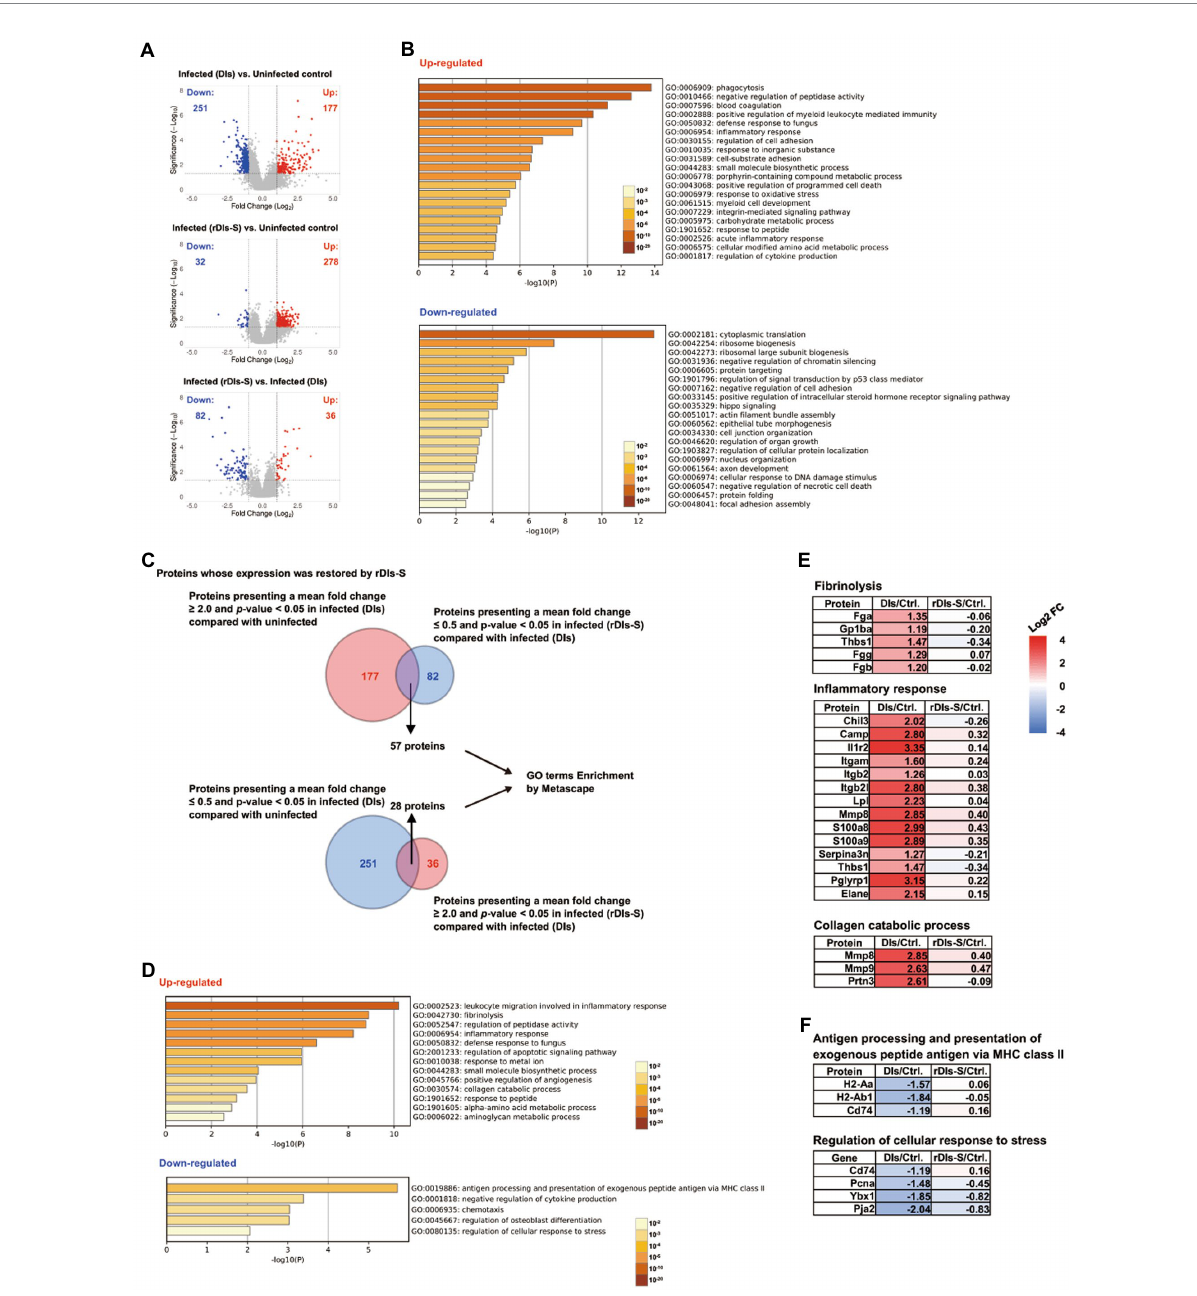
FIGURE 5 Proteomic analysis in vaccinated mice following SARS-CoV-2 infection. The protein expression levels in the lung tissues of hACE2 transgenic mice 7 days after challenge infection were analyzed using multiplex peptide labeling and mass spectrometry (MS). (A) Volcano plot for differentially expressed proteins. Comparison of the protein expression levels between uninfected mice and infected mice inoculated with DIs (top), between uninfected mice and infected mice inoculated with rDIs-S (middle), and between infected mice inoculated with DIs and infected mice inoculated with rDIs-S (bottom). x -axis: expression ratios. y -axis: p values of the comparisons. Vertical dotted lines indicate a 2-fold increase or decrease in the protein level in mice inoculated with DIs or rDIs-S. Horizontal lines indicate a p value of 0.05 from a Chi-squared test. Red circles: proteins with concentration increases of more than 2.0-fold in each comparison (DIs vs. Uninfected, rDIs-S vs. Uninfected, and rDIs-S vs. DIs); blue circles: proteins with concentrations decreased to less than half in each comparison (DIs vs. Uninfected, rDIs-S vs. Uninfected, and rDIs-S vs. DIs). (B) The top-20 gene ontology (GO) enrichment terms related to biological processes (BP) of the proteins that were upregulated (upper) and downregulated (lower), as analyzed by Metascape. (C) Number of proteins with altered expression in infected mice without vaccination for which expression was restored by rDIs-S vaccination. (D) GO enrichment terms related to BP of the genes encoding the proteins that were restored by rDIs-S vaccination among the upregulated (upper) and downregulated (lower) proteins in the infected (DIs-inoculated) mice. (E) Representative cluster of GO enrichment terms related to BP of the genes encoding the proteins that were restored by rDIs-S vaccination, among the upregulated proteins in the infected (DIs-inoculated) mice. (F) Representative cluster of GO enrichment terms related to BP of the genes encoding the proteins that were restored by rDIs-S vaccination, among the downregulated proteins in the infected (DIs-inoculated)